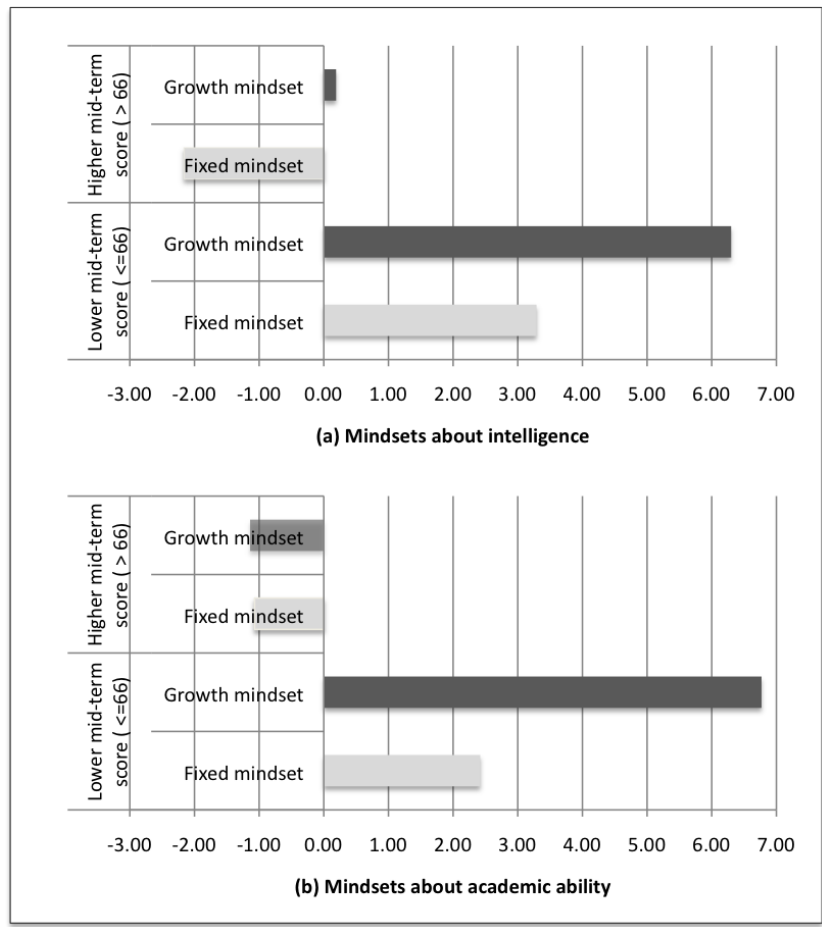
Figure 4. Score changes from mid-term to final exam for students obtaining lower and higher mid-term scores, based on their mindset about intelligence (panel a) and mindset about academic ability (panel